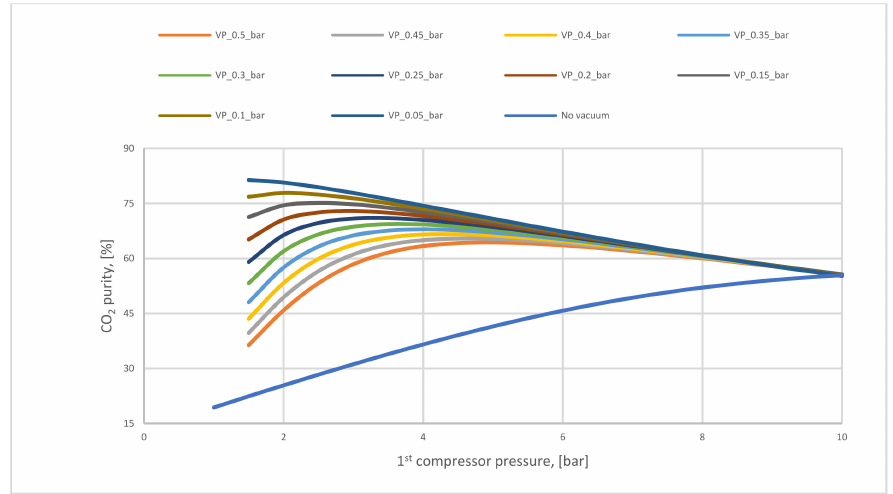
Figure 9. CO 2 purity variation regarding vacuum pump for 1-stage (case A, B) at different 1st compressor pressures and 200,000 m 2 of 1st membrane surface.